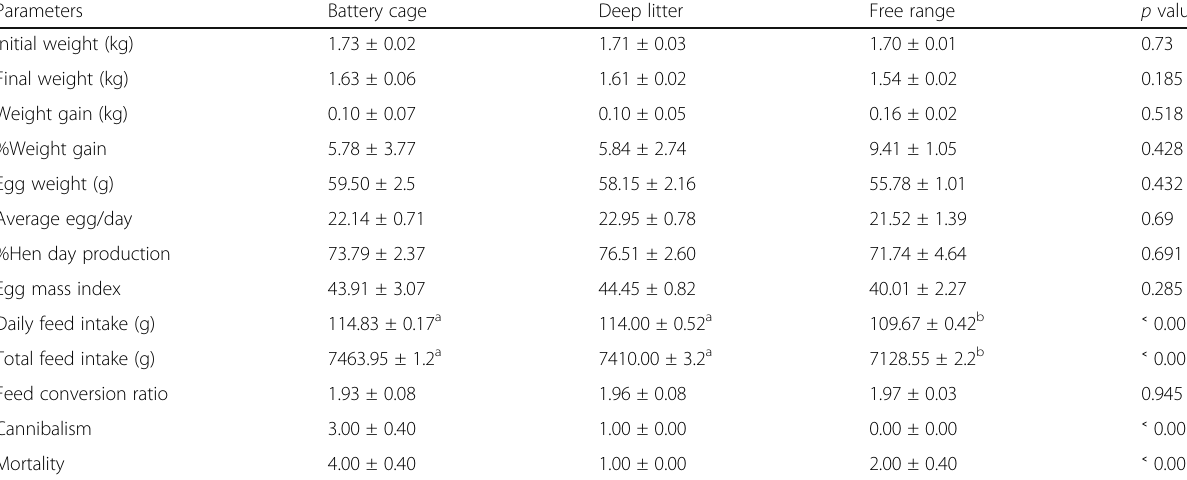
Table 2 Performance of Isa Brown layers reared on three different management systems Parameters